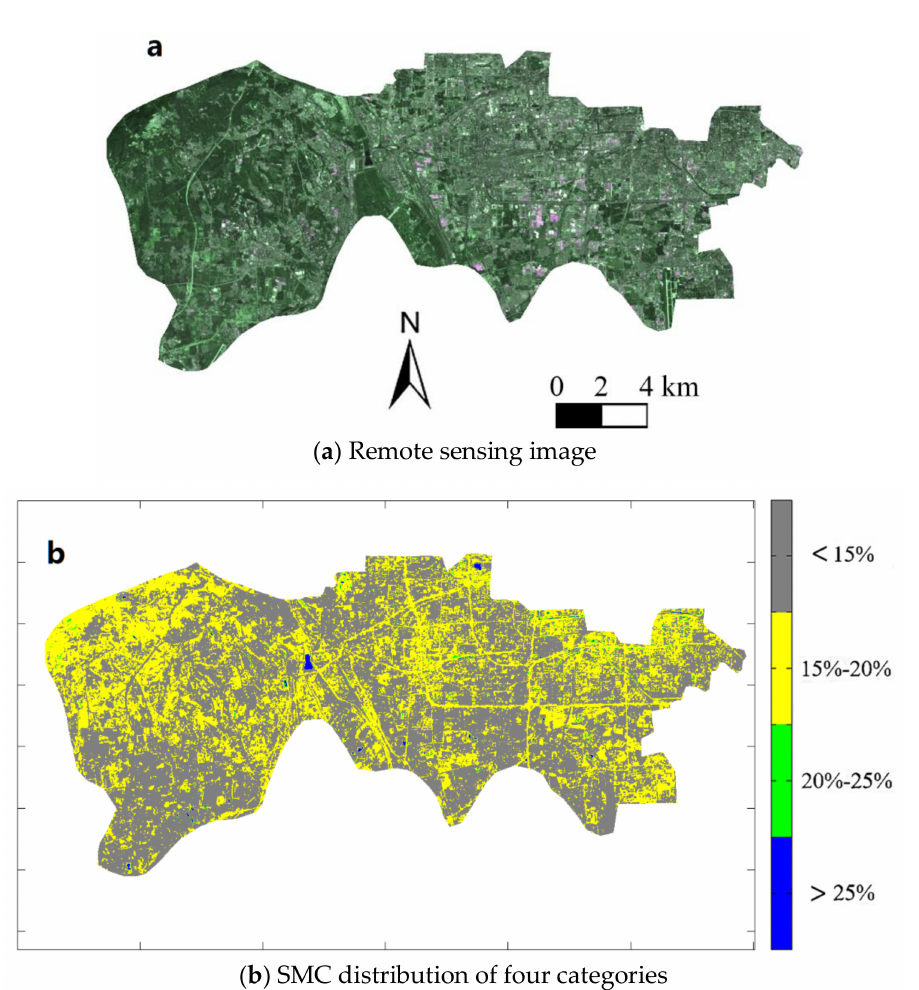
Figure 11. ( a ) The remote sensing image and ( b ) SMC distribution in the Fengtai District.